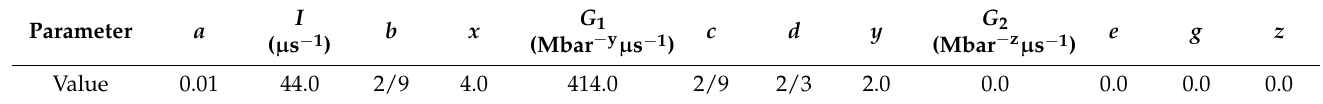
Table 2. The deterministic parameter values of Composition B in the Lee–Tarver equation of reaction rate.